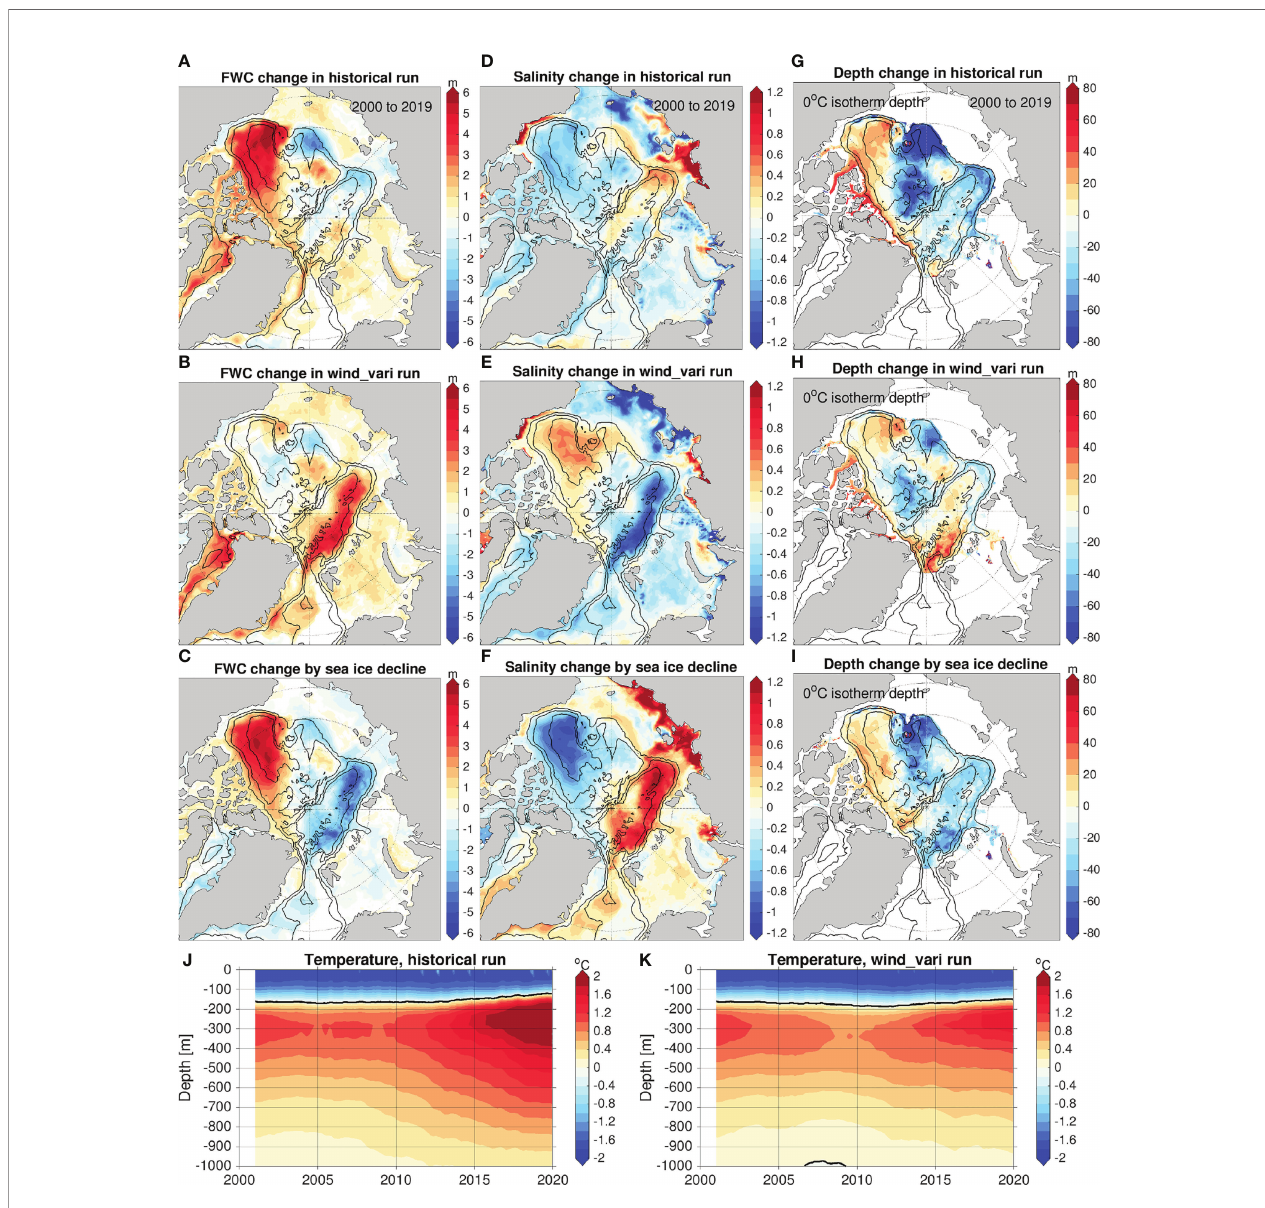
FIGURE 12 | Sea ice decline considerably contributed to Arctic Atlanti fi cation. (A) Change offreshwater content (FWC, m) from 2000 to 2019 in the historical simulation. (B) The same as (A) , but in the wind_vari simulation. (C) FWC change due to sea ice decline in this period, which is calculated as the difference between the historical simulation and wind_vari simulation. (D – F) The same as (A – C) , but for salinity averaged over the upper 150 m. (G – I) The same as (A – C) , but for the depth of the 0°C isotherm. (J) Time-depth plot (Hovmöller diagram) of monthly ocean temperature in the eastern Eurasian Basin between 80°E and 143°E where bottom topography is deeper than 500 m in the historical simulation. (K) The same as (J) , but for the wind_vari